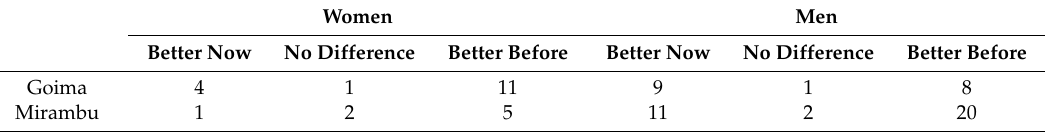
Table 9. Is life better or worse now than at the last survey by village and gender of the domestic unit